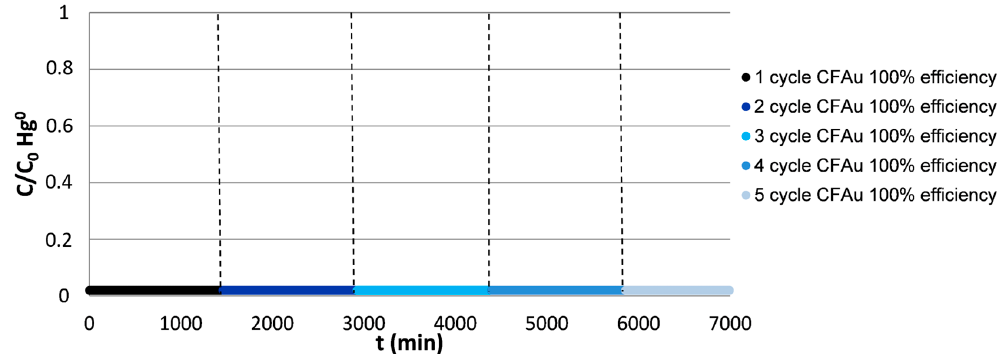
Figure 5. Mercury adsorption on CF-Au in an atmosphere containing CO 2 , N 2 , SO 2 and HCl. Table 2. Absolute mercury retention ( R ) and percentages of mercury retained (% Hg ret ) and oxidized (% Hg 2+ ) in CF-Au in each cycle in an atmosphere containing CO 2 , N 2 , SO 2 and HCl, over 1440 min.